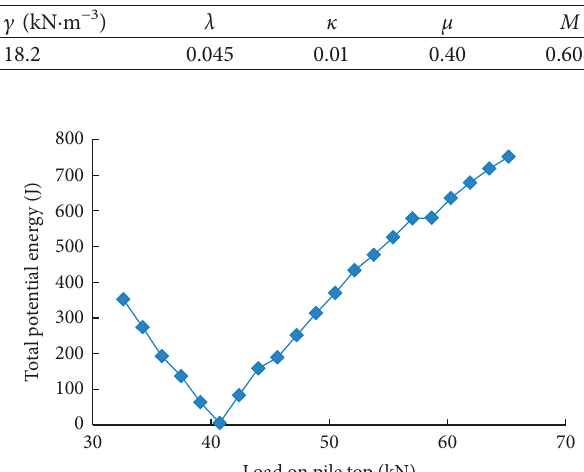
Table 3: Physical mechanical index of soils.